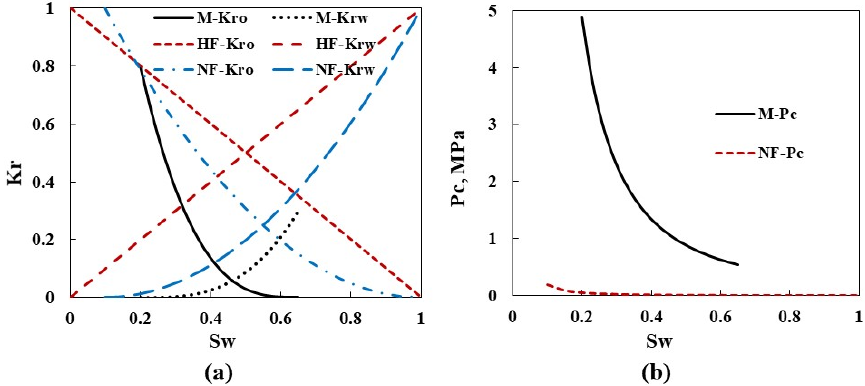
Figure 1. ( a ) Relative permeability curve. ( b ) Capillary pressure curve.